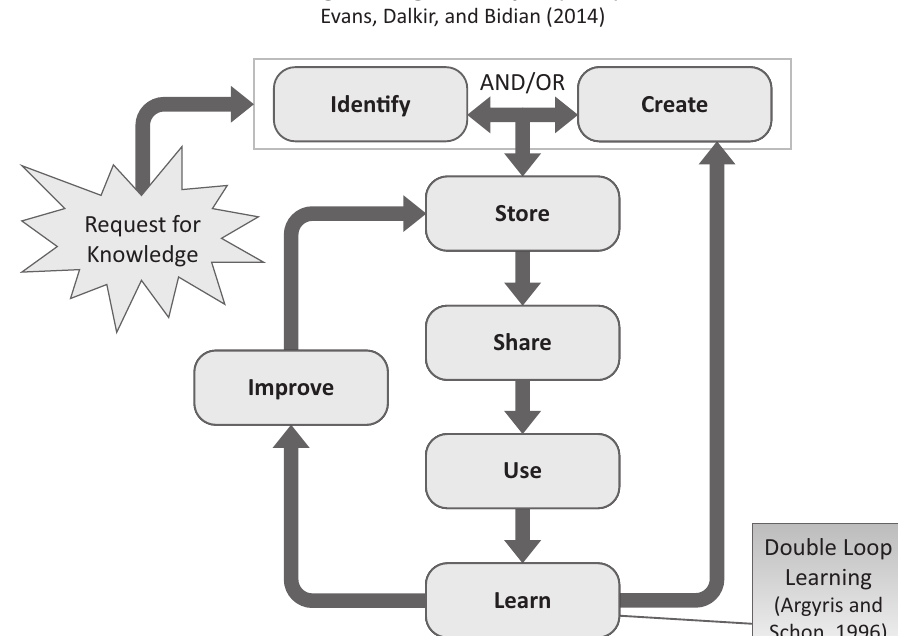
Figure 1. The KMLC. Source: Evans et al. (2015, p. 85). knowledge gap analysis or innovation (Evans et al.,